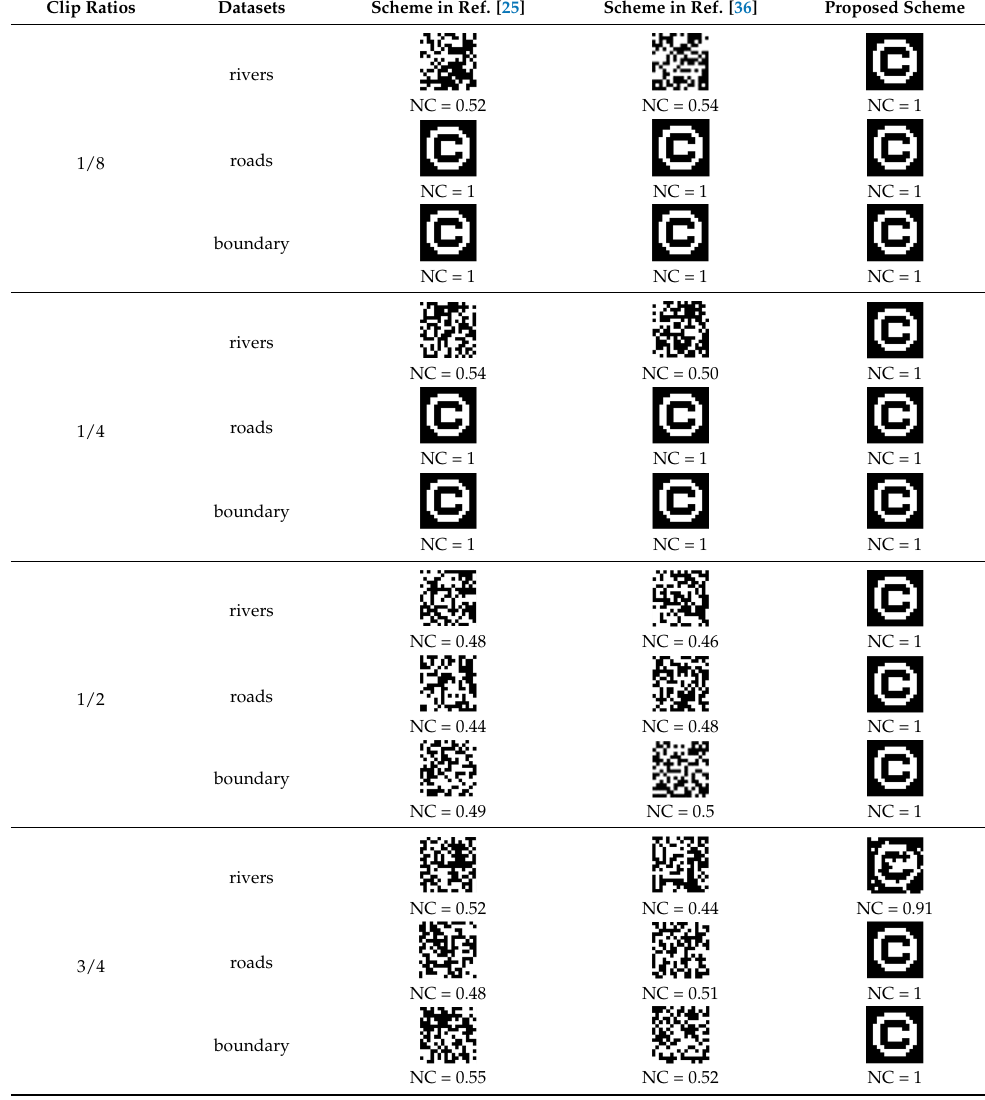
Table 4. The results of cropping attacks.